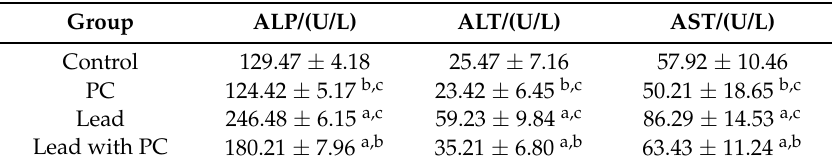
Table 3. The effect of PCs on serum enzyme levels in mice ( n = 7, X ± s).